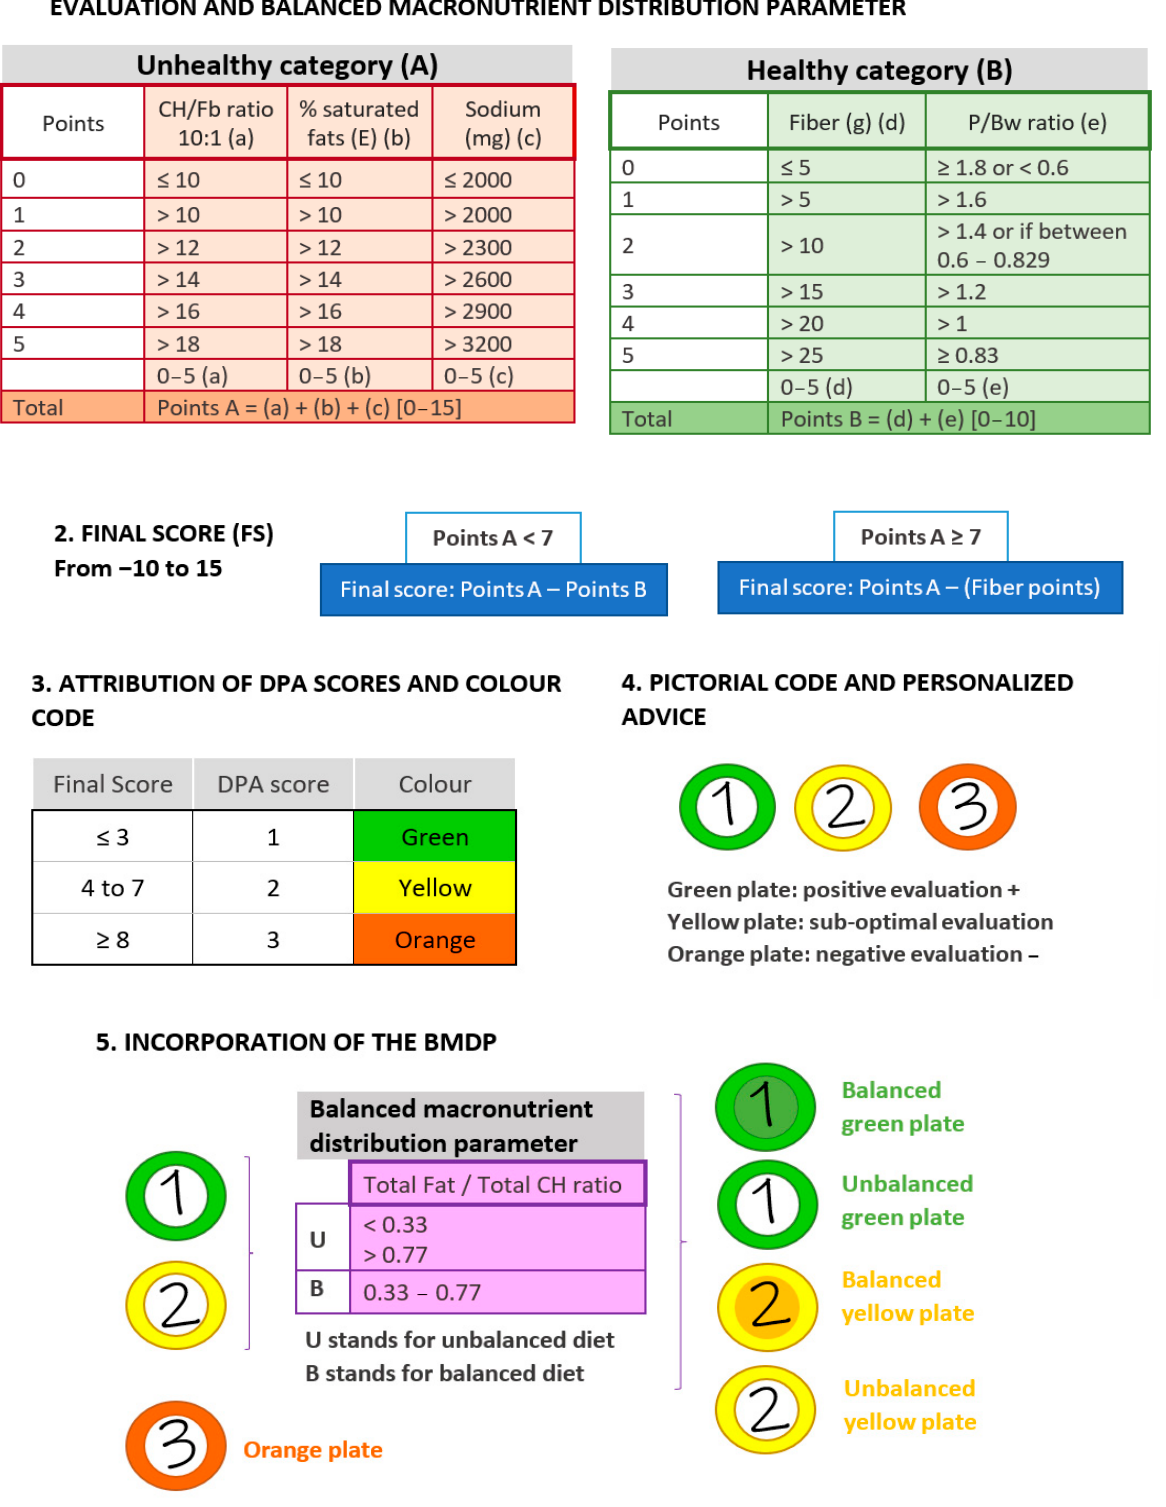
Figure 1. Components and scores of the DPA, a diet profiling algorithm to assess diet quality. The figure shows the sequential checkpoints considered by the DPA, displaying the points attributed and the range of application and the proposed final outputs. Abbreviations: DPA: diet